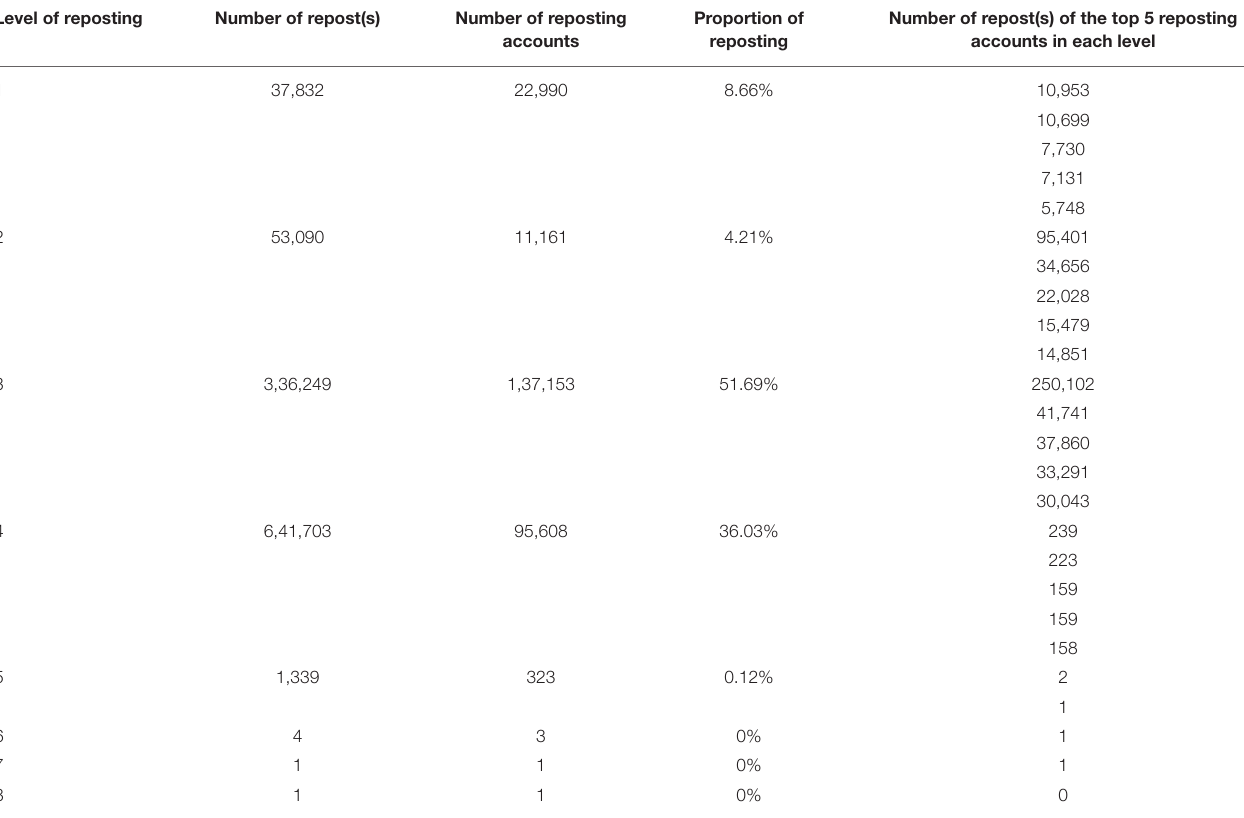
TABLE 1 | Spreading of the most influential “#national mask campaign#” post by levels of reposting on Sina Weibo. Level of reposting Number of repost(s) Number of reposting